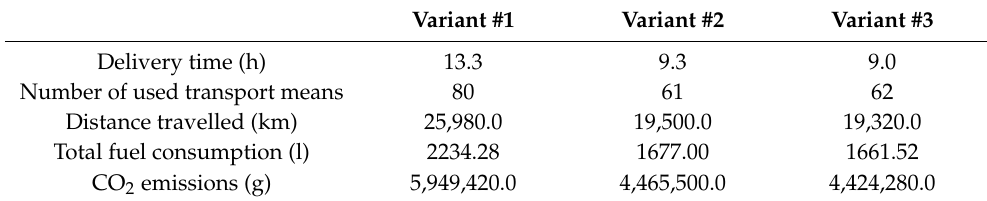
Table 18. Summary table of results.